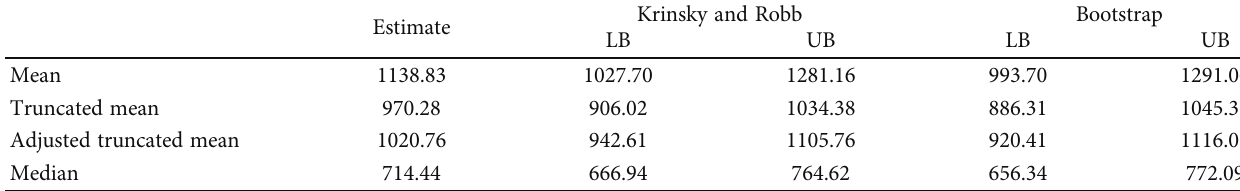
Table 12: Con fi dence intervals for the WTP of log-logistic model (source: authors). Estimate